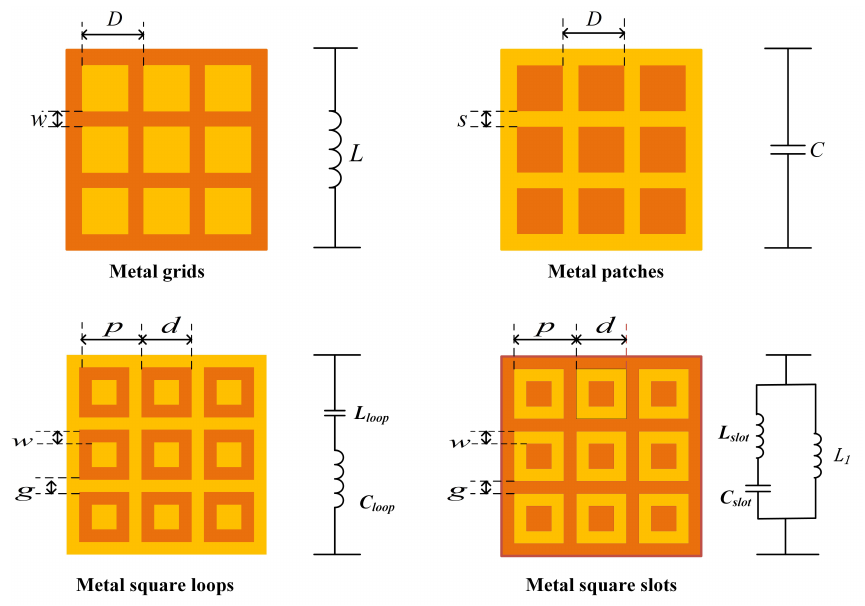
Figure 1. FSS building blocks and its